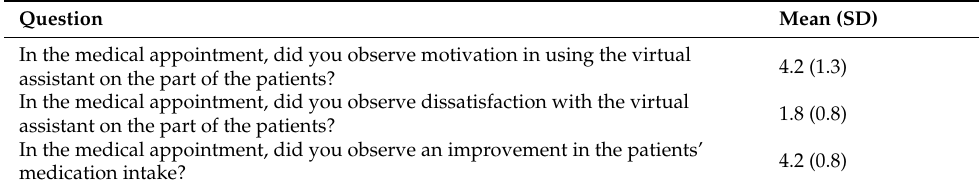
Table 9. Healthcare professionals’